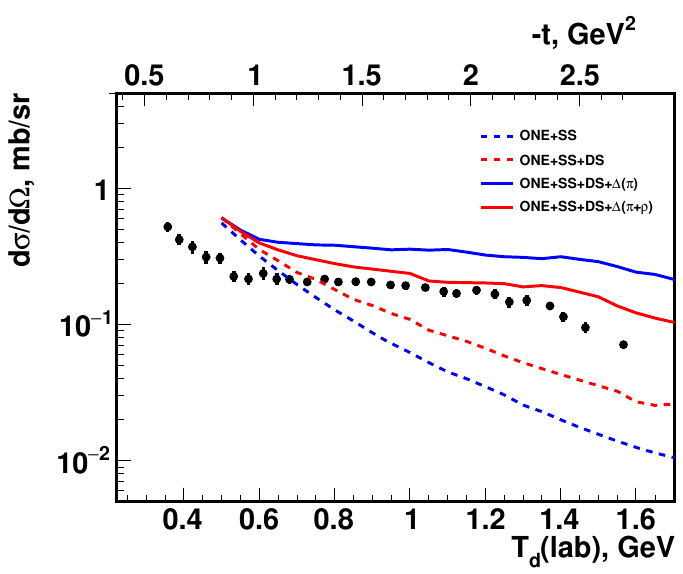
Figure 6: The energy dependence of the differential cross section at the scattering angle θ ∗ = 180 ◦ . The data are from [ 26 ]